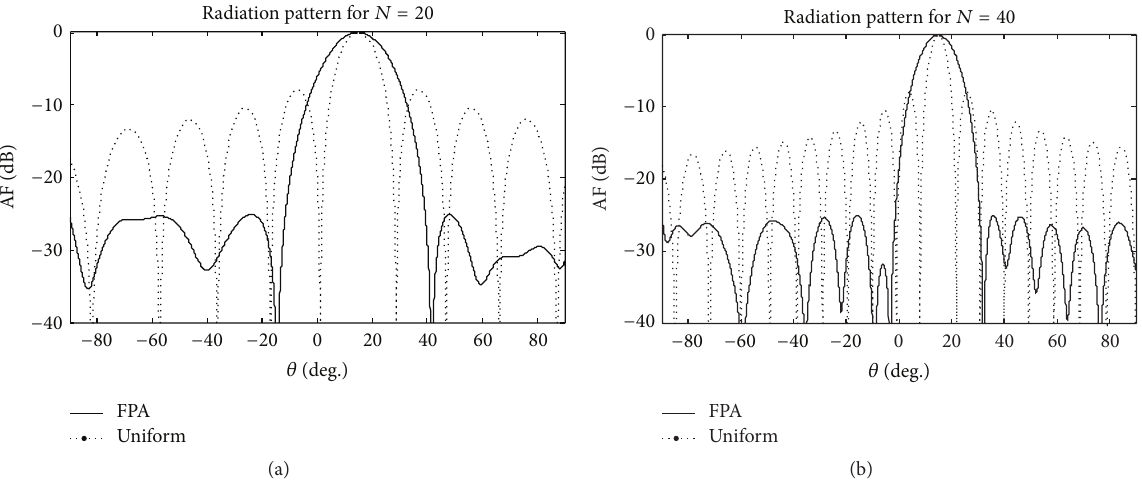
Figure 6: Comparison radiation patterns of CAA with main beam scanned to 15 ∘ using weights obtained by FPA and uniform distribution for (a) 𝑁 = 20 and (b) 𝑁 = 40